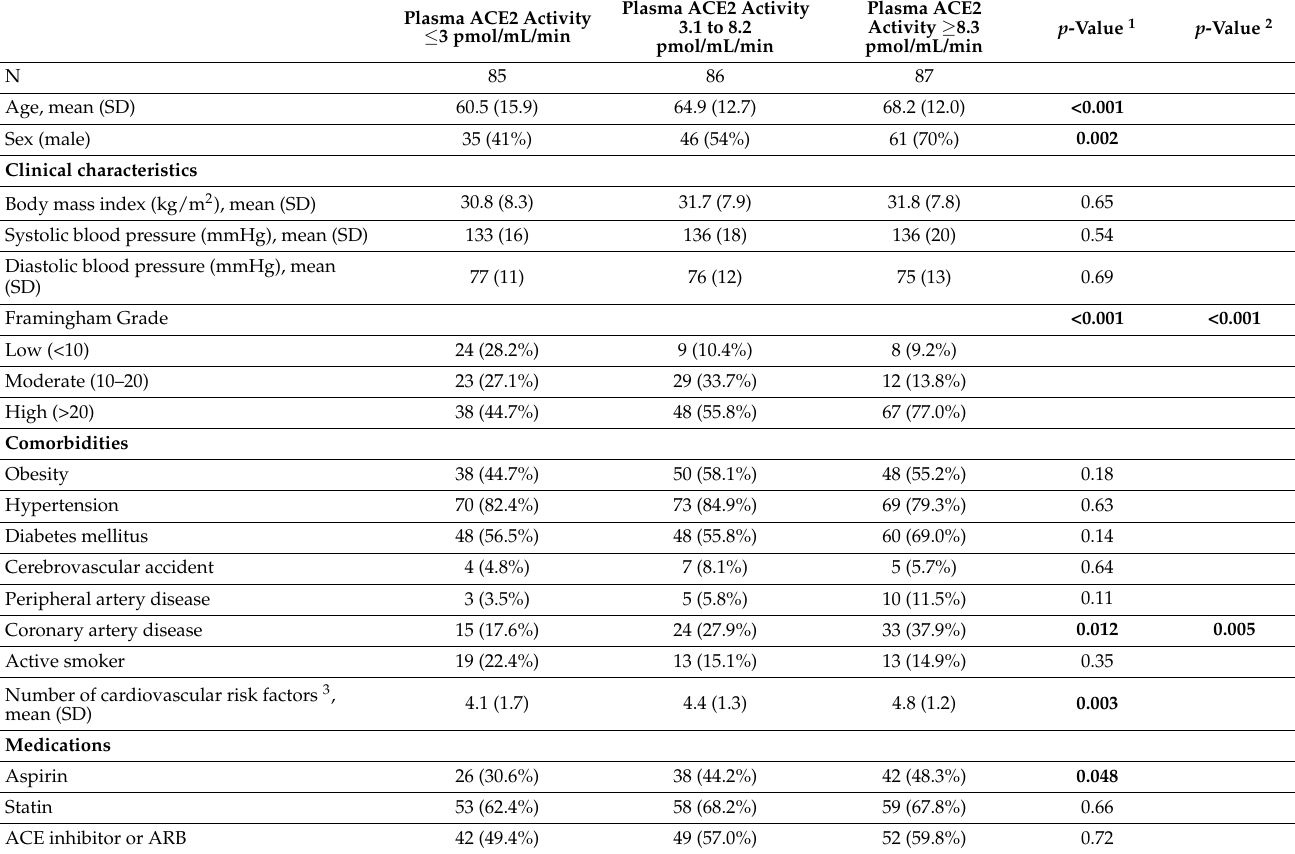
Table 3. Plasma ACE2 activity levels reported in tertiles according to cardiovascular risk factors and/or disease and baseline